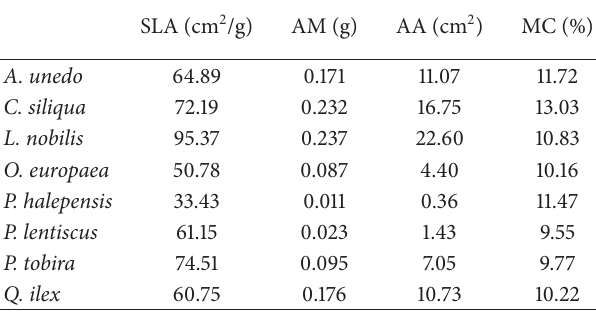
Table 2: Physical parameters of tested leaf litter.